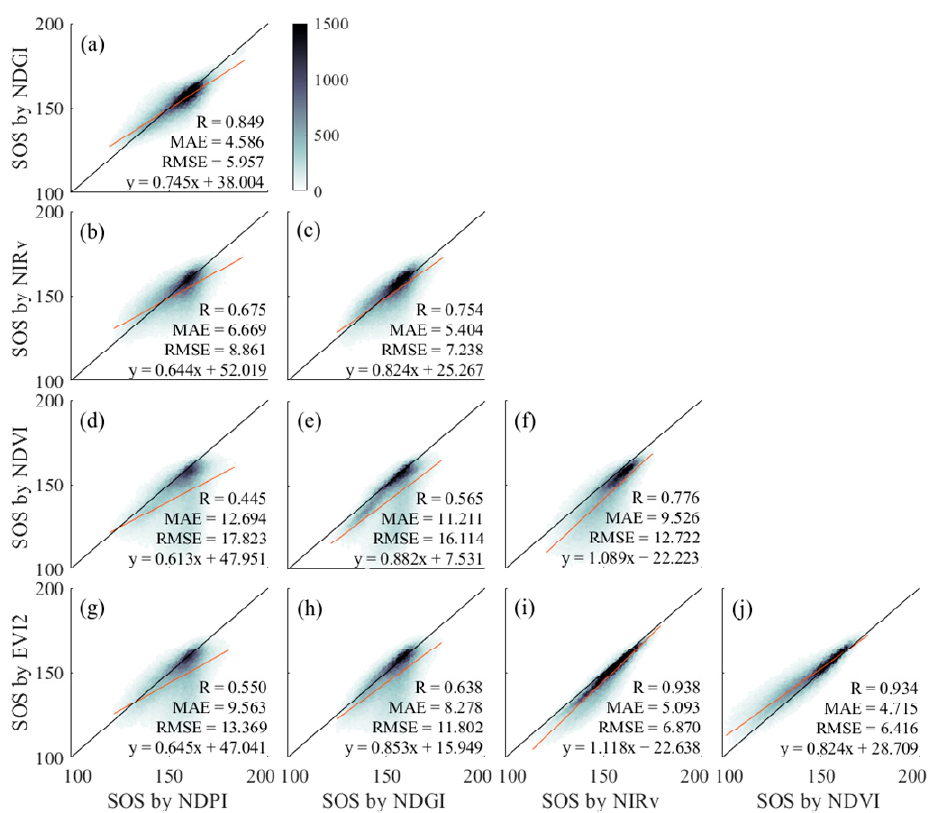
Figure 9. Comparison of the SOS detected by different VIs. The color from light gray to dark gray indicates increasing sample densities. ( a )-( j ) are scatterplots of the SOS dates detected from different VIs on a pixel-by-pixel basis.